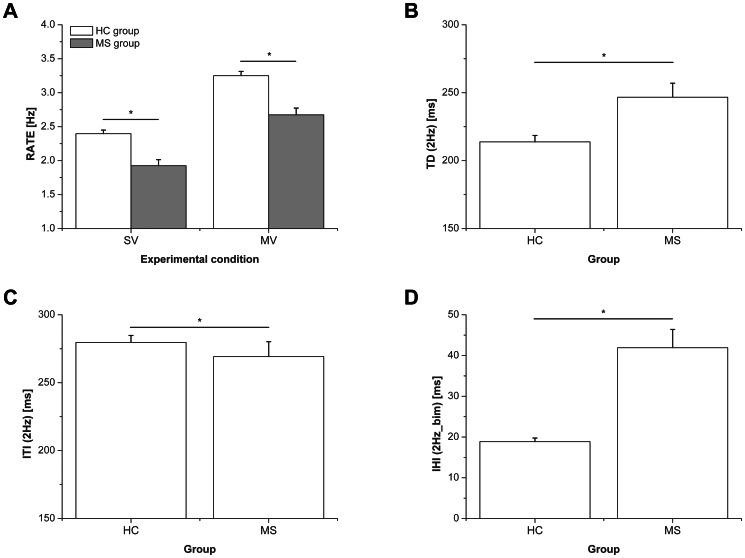
Comparison of the motor performance parameters between the two groups (HC and MS).(A) RATE in the spontaneous and maximal velocity conditions, (B) Touch Duration in the 2 Hz condition, (C) Inter Tapping Interval in the 2 Hz condition, (D) Inter Hand Interval in the 2 Hz_bim condition. * indicates statistically significant difference between the two groups (HC and MS). Error bars indicate standard error of the mean.